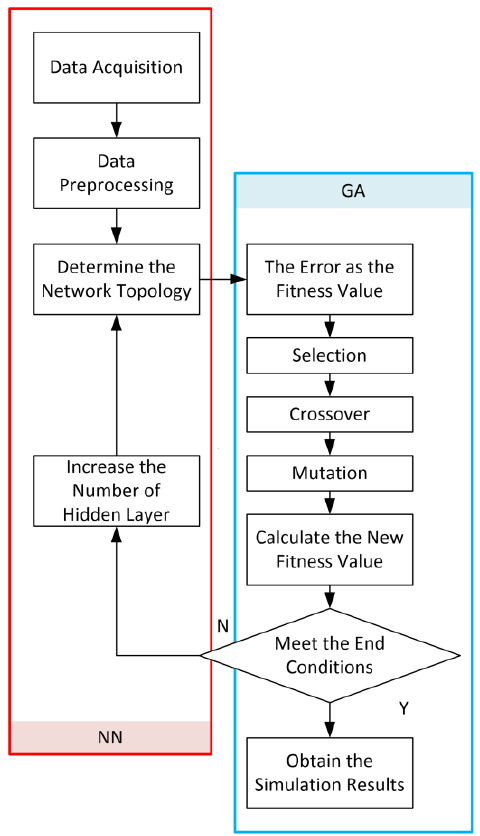
Figure 4. Flow chart of hybrid learning of GA-based ANN.